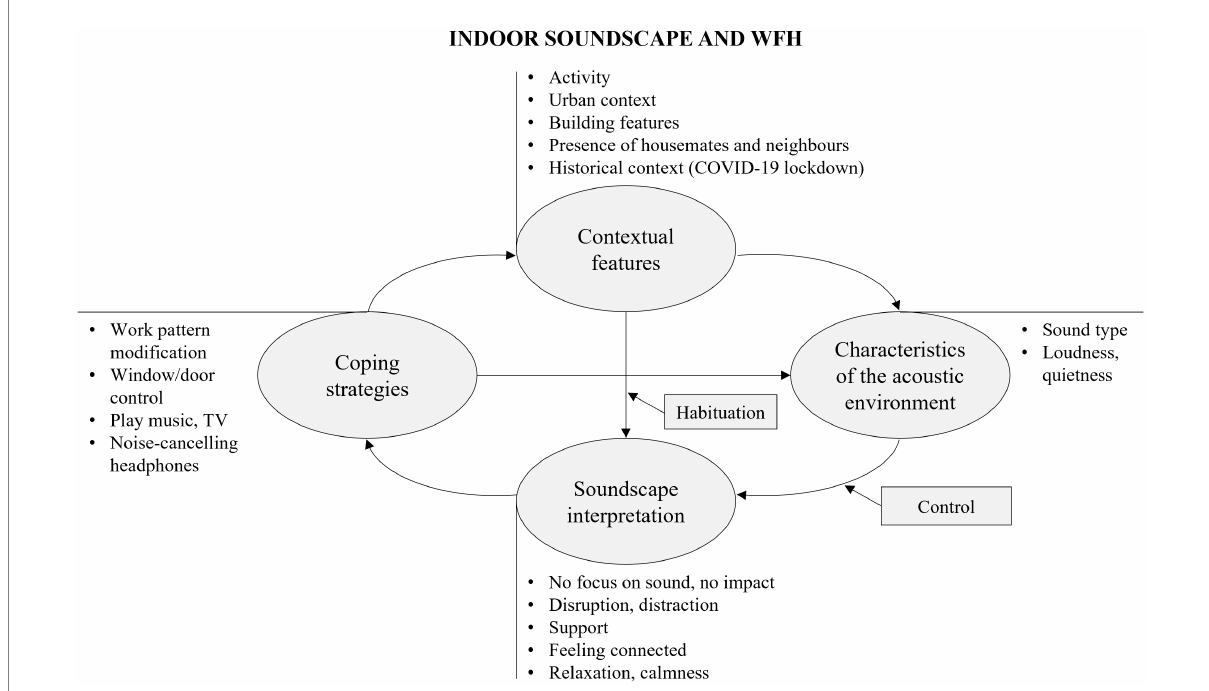
FIGURE 1 Thematic map on the relationship between indoor soundscape and WFH showing themes (within rounded boxes) and sub-themes, together with their causal interconnections and moderating factors (within squared